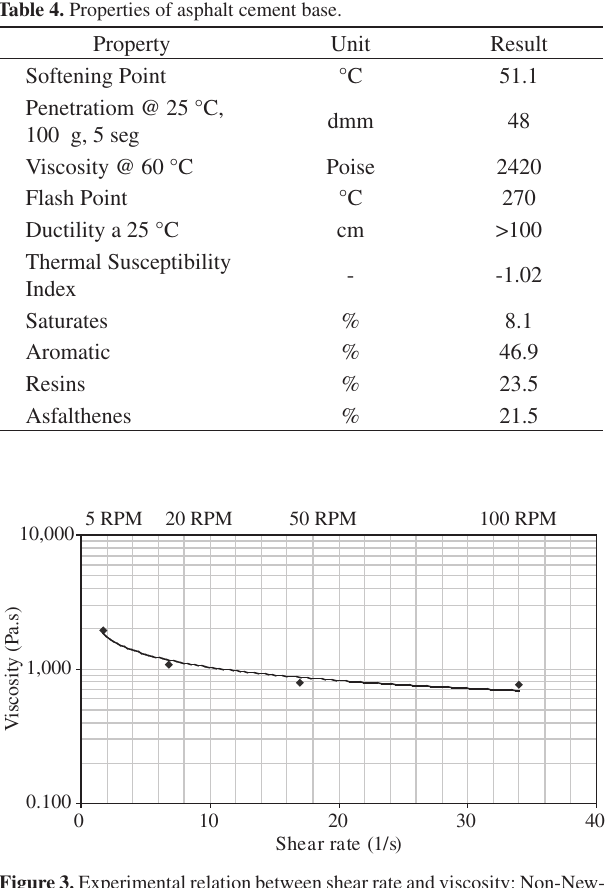
Figure 3. Experimental relation between shear rate and viscosity: Non-New- tonian behavior of asphalt rubber.